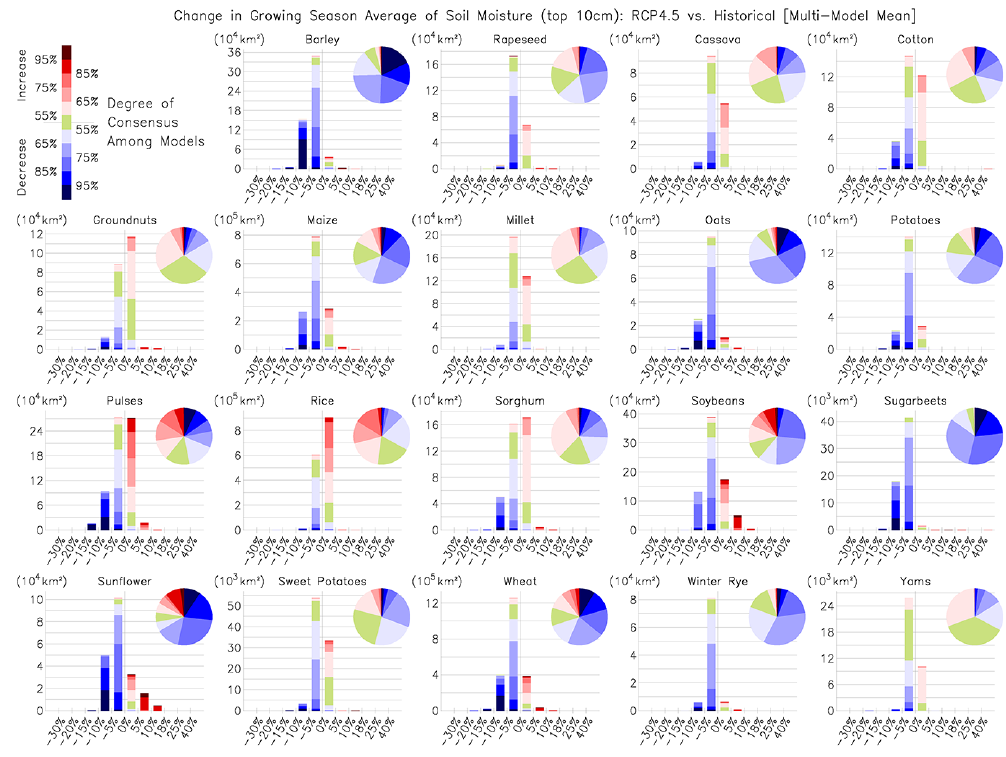
Figure 8. As in Fig. 7 but for changes from the historical case to the RCP4.5 case.